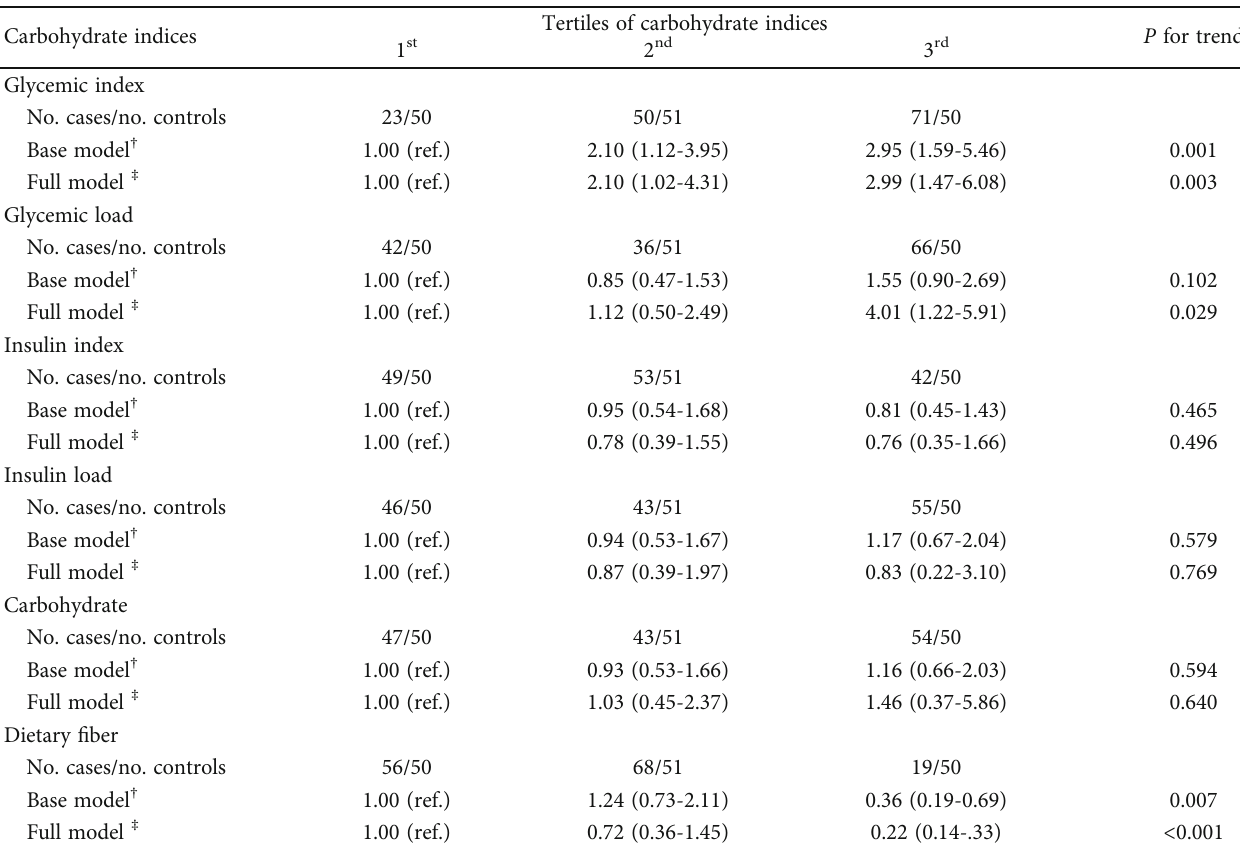
Table 3: Adjusted odds ratio (OR) estimates and 95% con fi dence intervals (CIs) for bacterial vaginosis according to the tertile of carbohydrate indices ∗